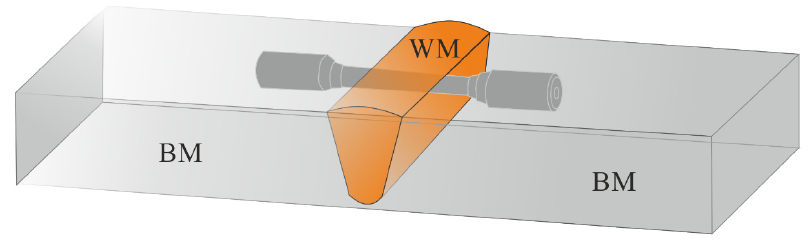
Figure 1. Schematic of the specimens prepared for mechanical tests from the welded joint.